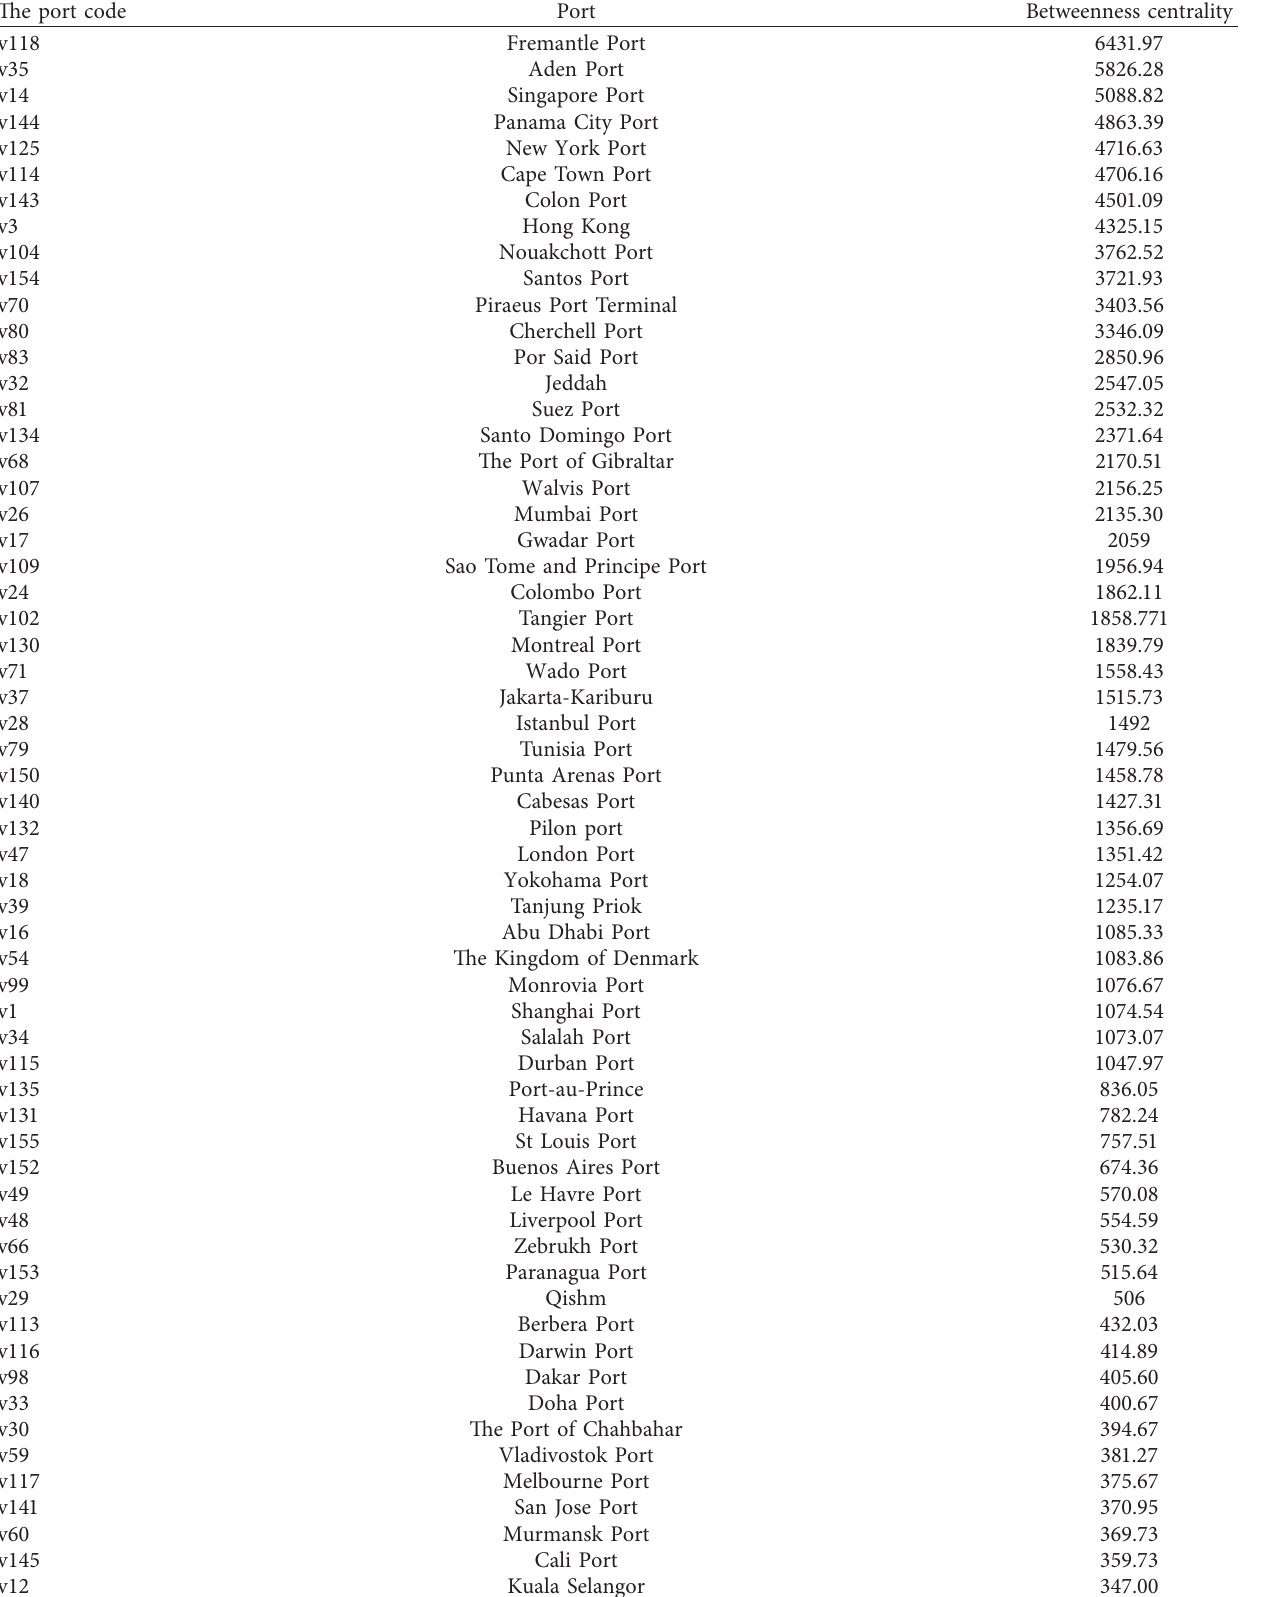
Table 5: The betweenness centrality for each port.